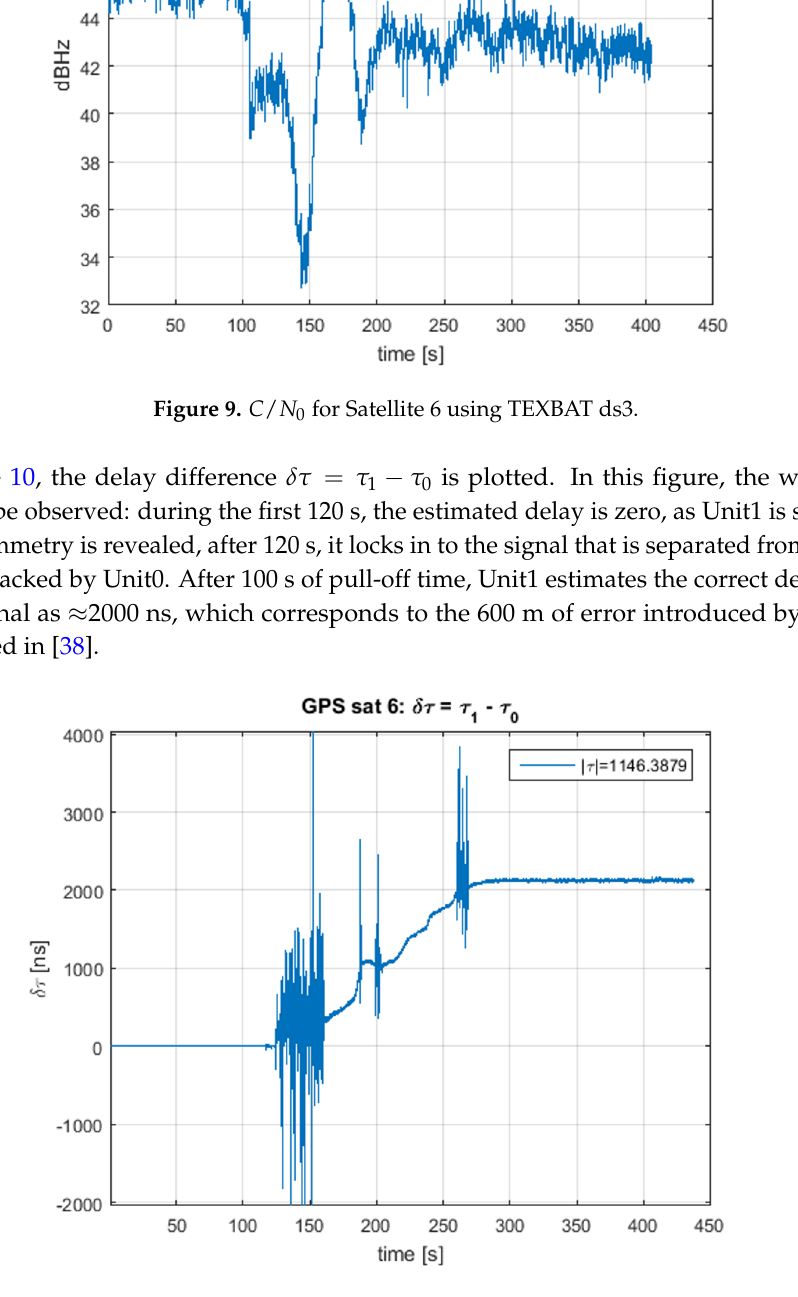
Figure 10. Delay difference between Unit1 and Unit0 for TEXBAT